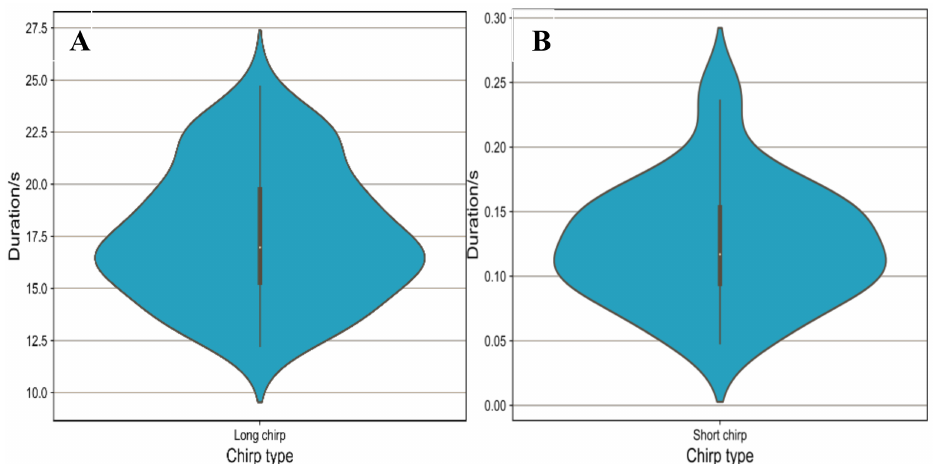
Figure 3. Ranges of long ( A ) and short ( B ) calls of plateau pikas. In the violin plots, the lower and upper edges of the box represent the 25% (q1) and 75% (q3) quartiles, respectively. The white dot inside the box represent the median (md).